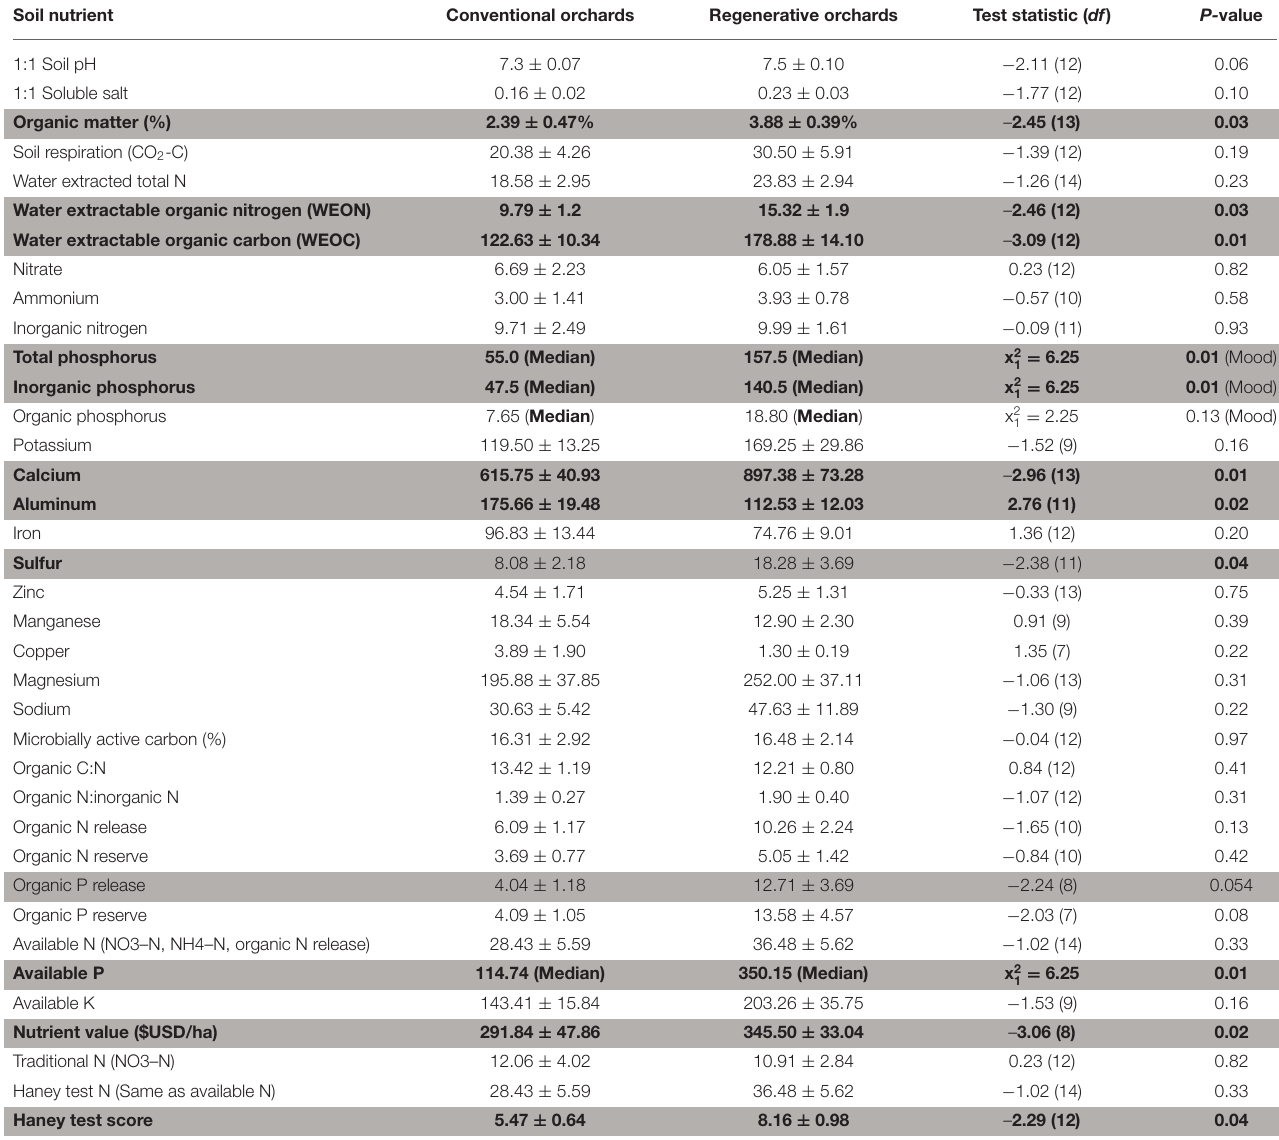
TABLE 2 | Soil nutrients in regenerative and conventional orchards ( N =